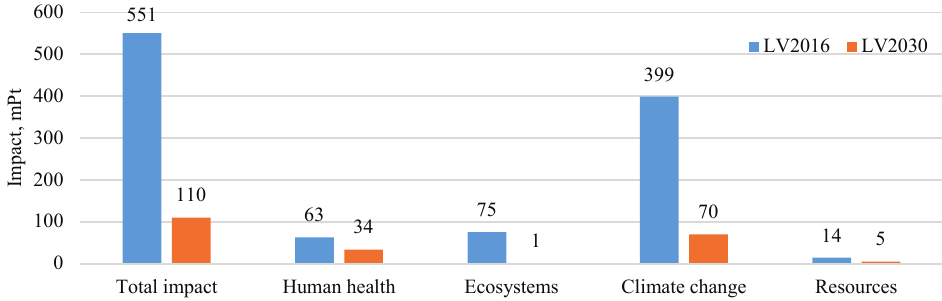
Fig. 2. Comparison of the life cycle analysis of both scenarios in the environmental impact categories of the results. The overall impact assessment shows that the environmental impacts of the scenario LV2030 is approximately 80 % lower compared to the LV2016 scenario – 551 mPt per capita in 2016 and 110.1 mPt per capita in 2030 (Fig. 2). The main preconditions for such an impact reduction are the increase in MW sorting and recycling volume, a reduction in the amount of MW landfilled in waste sites and the separation of the biodegradable fraction from the total flow that improves the quality and volume of biogas